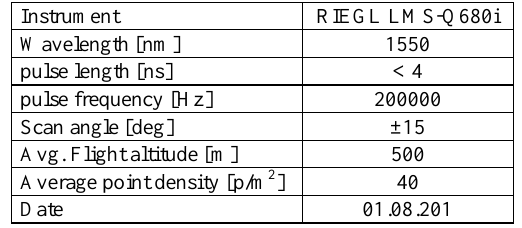
Table 2. Specification of the ALS instrument (Leiterer et al., 2010).